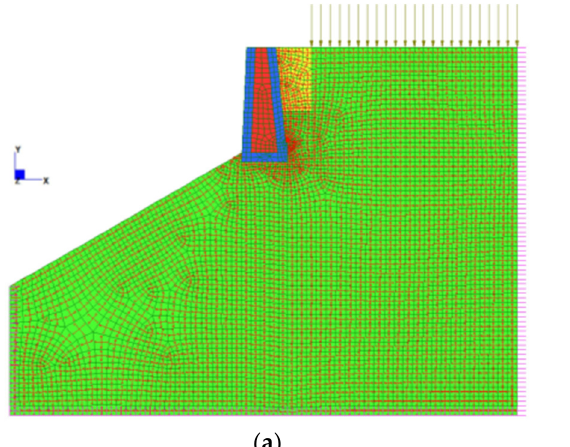
Figure 5. LEM analysis of sections 92–93 (Table 1) with the software SSAP2000 [73]. Surface failure ( a ) and contour of the safety factors ( b ).